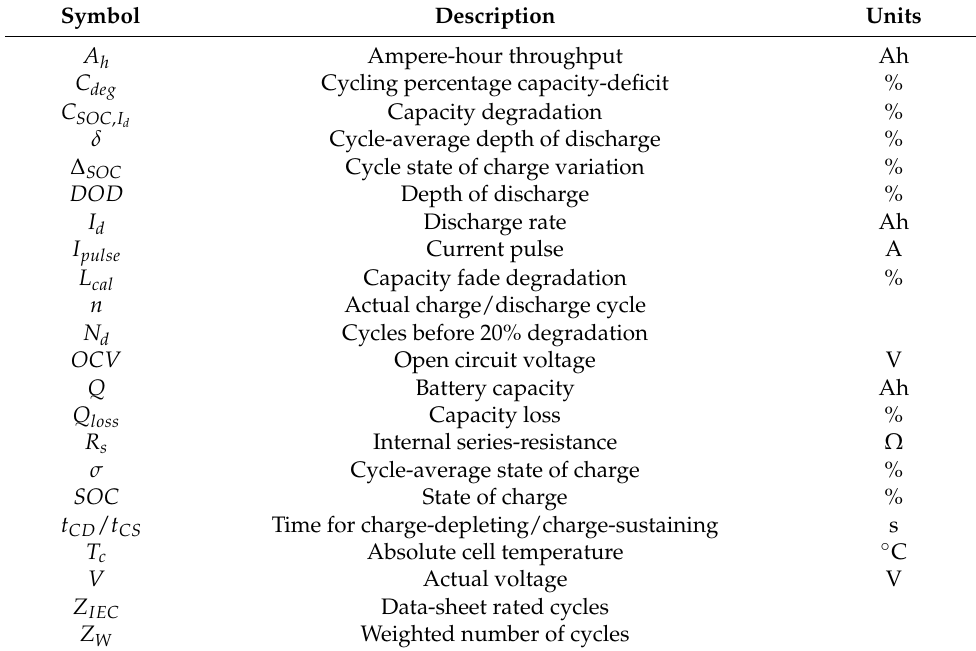
Figure 4. Illustration of a Li-ion battery cell’s construction. Two electrodes, a porous separator, an electrolyte, and two current collectors are the main components. The released electricity is generated by the difference in the cohesive or bond energies of the metals, oxides, or molecules undergoing the electrochemical reaction because of the electrolyte. The electrolyte contains metal cations reduced (electrons are added) at the cathode, while metal atoms are oxidized (electrons are removed) at the anode [44]. Table 3. Nomenclature for